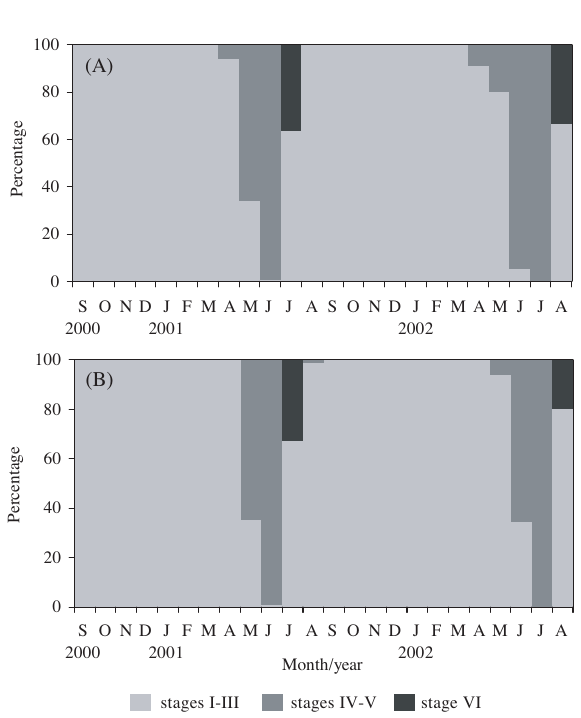
F IG . 4. – Monthly percentage of maturity stages of (A) male and (B) female round sardinella, Aegean Sea.